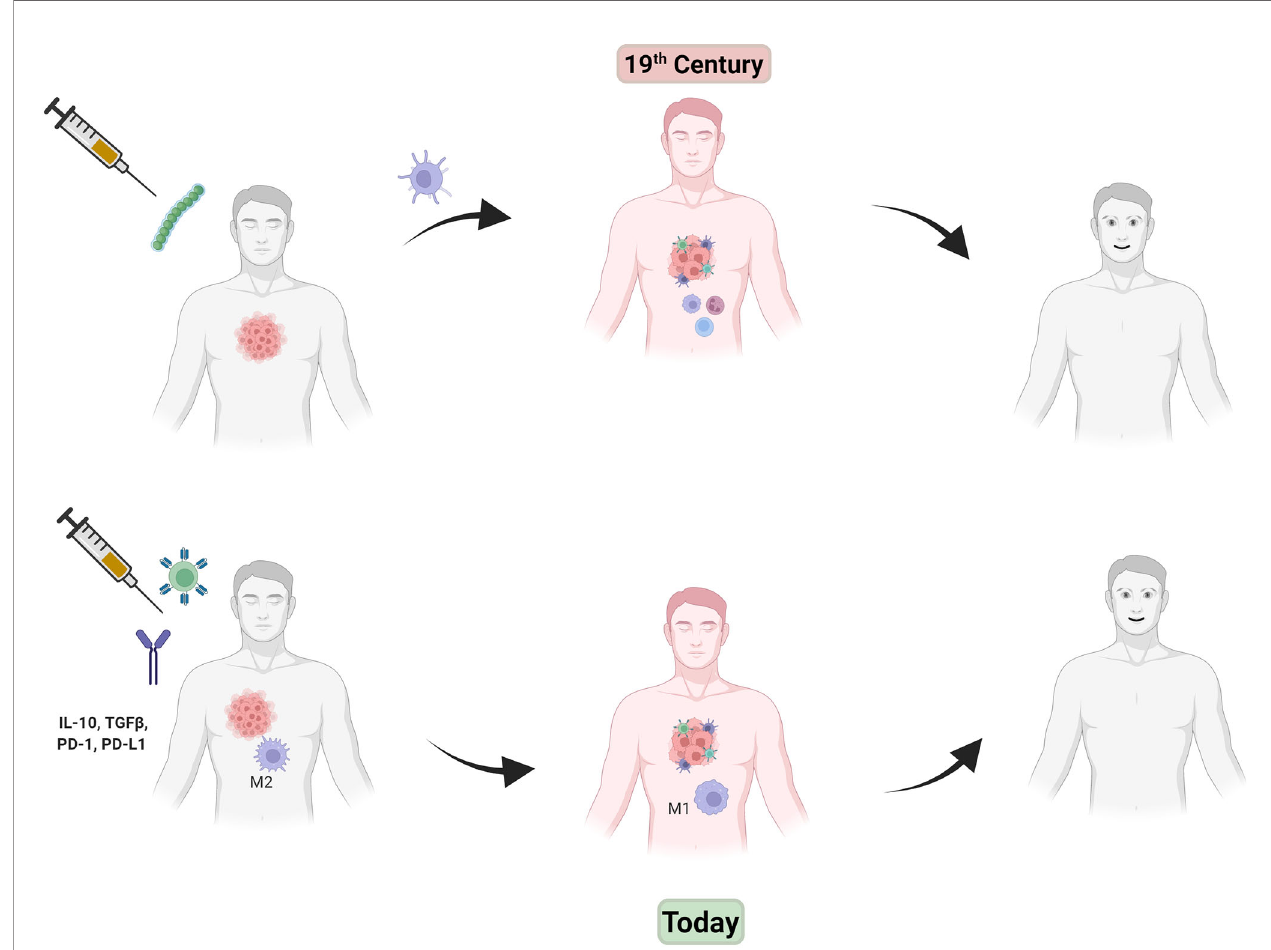
FIGURE 1 | In the late 19 th century, injection of Coley ’ s toxin (green beads, top left) caused an in fl ammatory immune response (center drawing, red man with immune cells attacking tumor) that helped tumor regression. Modern day immunotherapy (lower drawings, left to right) shows injection of CAR-T cells (green spiked ball) and/or checkpoint inhibitor antibodies (IgG fi gure) results in a similar effect without the use of toxic